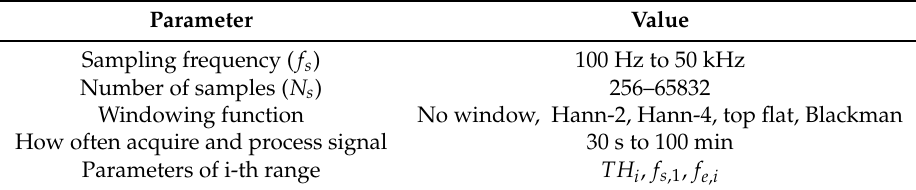
Table 1. Configurable parameters via Bluetooth Low-Energy.